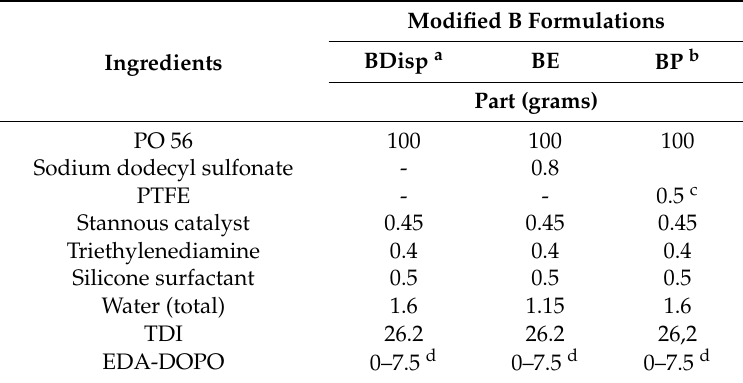
Table 3. Modifications of formulation